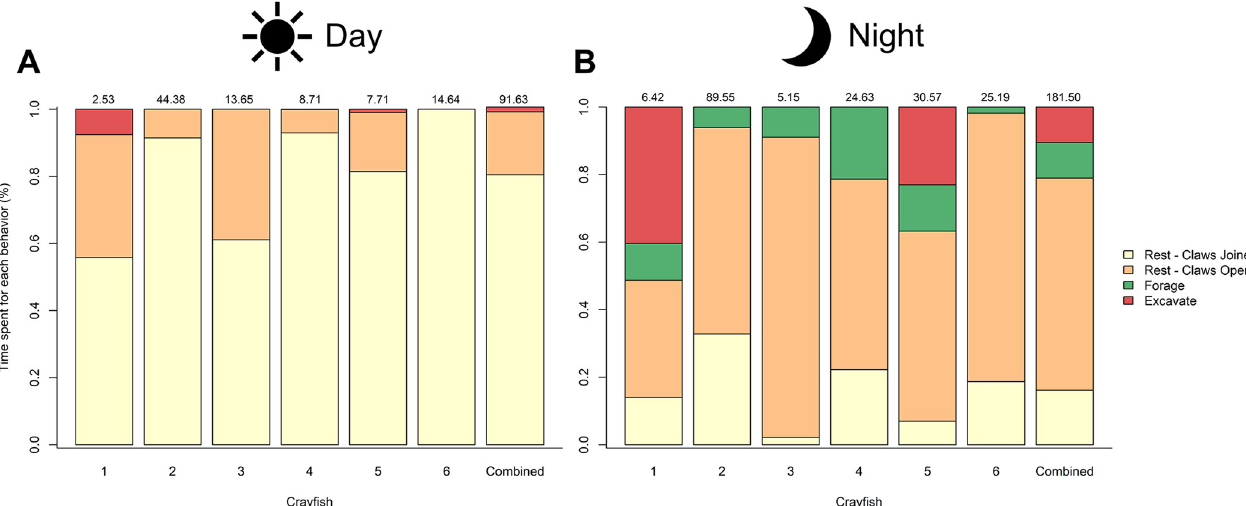
Fig 7. The percentage of time that each Lacunicambarus thomai spent exhibiting different behaviors throughout the (A) day and the (B) night. We report the percentage of time that each individual crayfish spent during the day and the night and combined six crayfish. The hunt behavior was not included in because of the relatively small time that this behavior was exhibited. For each crayfish, the total number of time (hours) that each crayfish was filmed active is listed above the bar.